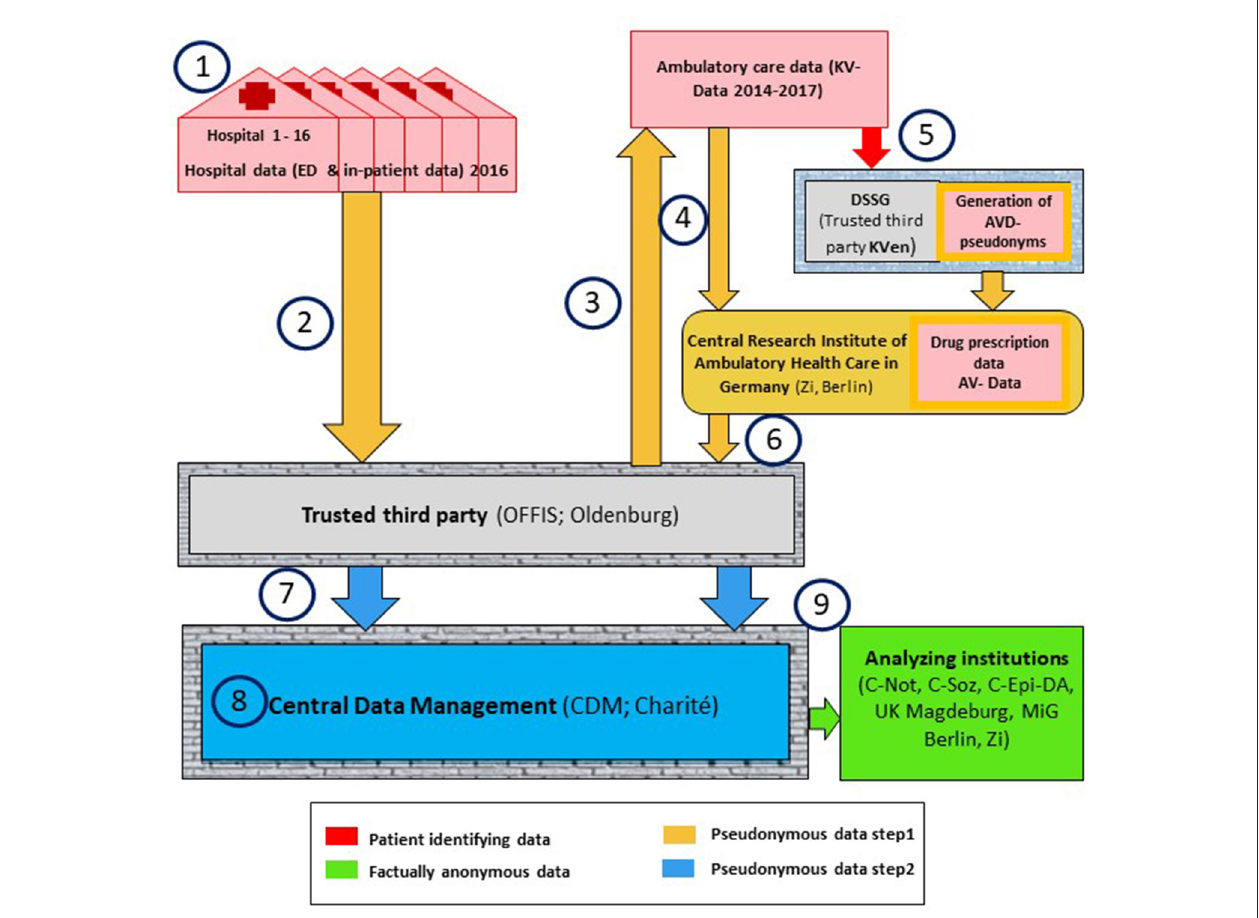
FIGURE 3 | Schematic overview of the data flow in INDEED scenario 1. ED, emergency department; OFFIS, Institute for Information Technology; Oldenburg, trusted third party of the project data; CDM, Central Data Management; KV-data, the outpatient care data originating from the KV; DSSG, Service & Support GmbH (KV data trusted third party); AV-data, medical prescription data; C-Not, Emergency and Acute Medicine (CVK, CCM); Charité, Universitätsmedizin Berlin; C-Soz, Institute of Medical Sociology and Rehabilitation Science; Charité, Universitätsmedizin Berlin; C-Epi-DA, Institute for Social Medicine, Epidemiology and Health Economics; Charité, Universitätsmedizin Berlin, Data analizes; UK Magdeburg, Department of Trauma Surgery; Otto von Guericke University Magdeburg, MiG Berlin, Dept. Health Care Management, Berlin University of Technology; Zi, Central Research Institute of Ambulatory/Outpatient Health Care in